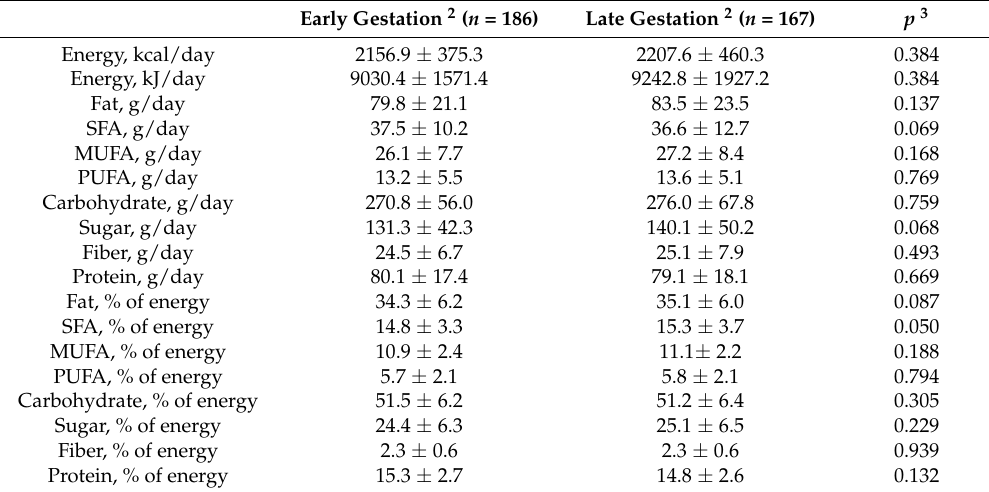
Table 2. Maternal dietary intake at early and late gestation 1